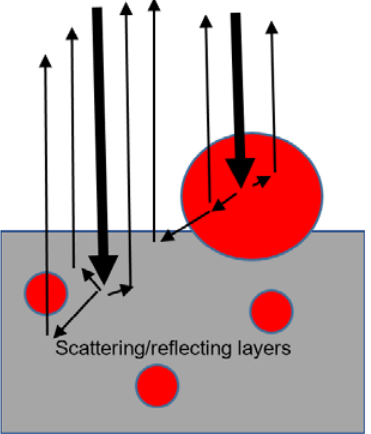
Figure 4. Schematic cross-section of the retina (grey), which includes cross-sections of a retinal vessel (arteriole or venule) and retinal capillaries (red), and possible trajectories of light that illuminates the retina. The incident light (broad black rays) illuminates the vessel and its neighborhood. The light that strikes the vessel and the neighboring tissue is scattered and backscattered by the blood and the tissue (thin rays). Most of the scattered/reflected light from the neighboring tissue is not affected by absorption in the blood, but some photons are affected by blood in the retinal vessel or the retinal capillaries.